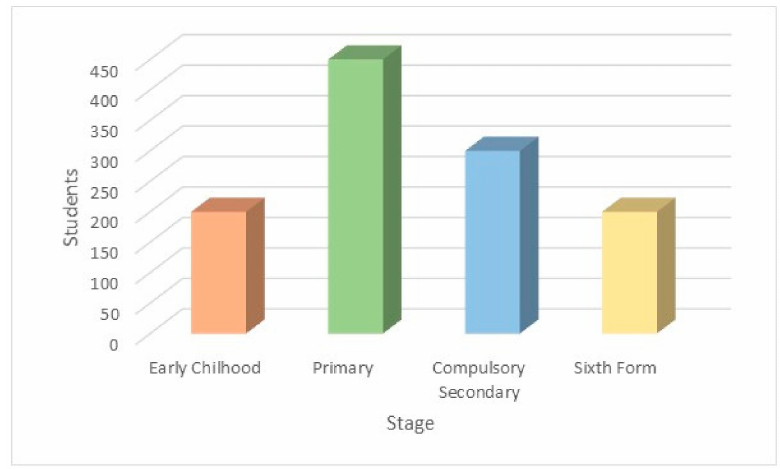
Figure 9. Average annual involvement in the Geoschools programme by stage of schooling. Source: compiled using data provided by the UNESCO Global Geopark